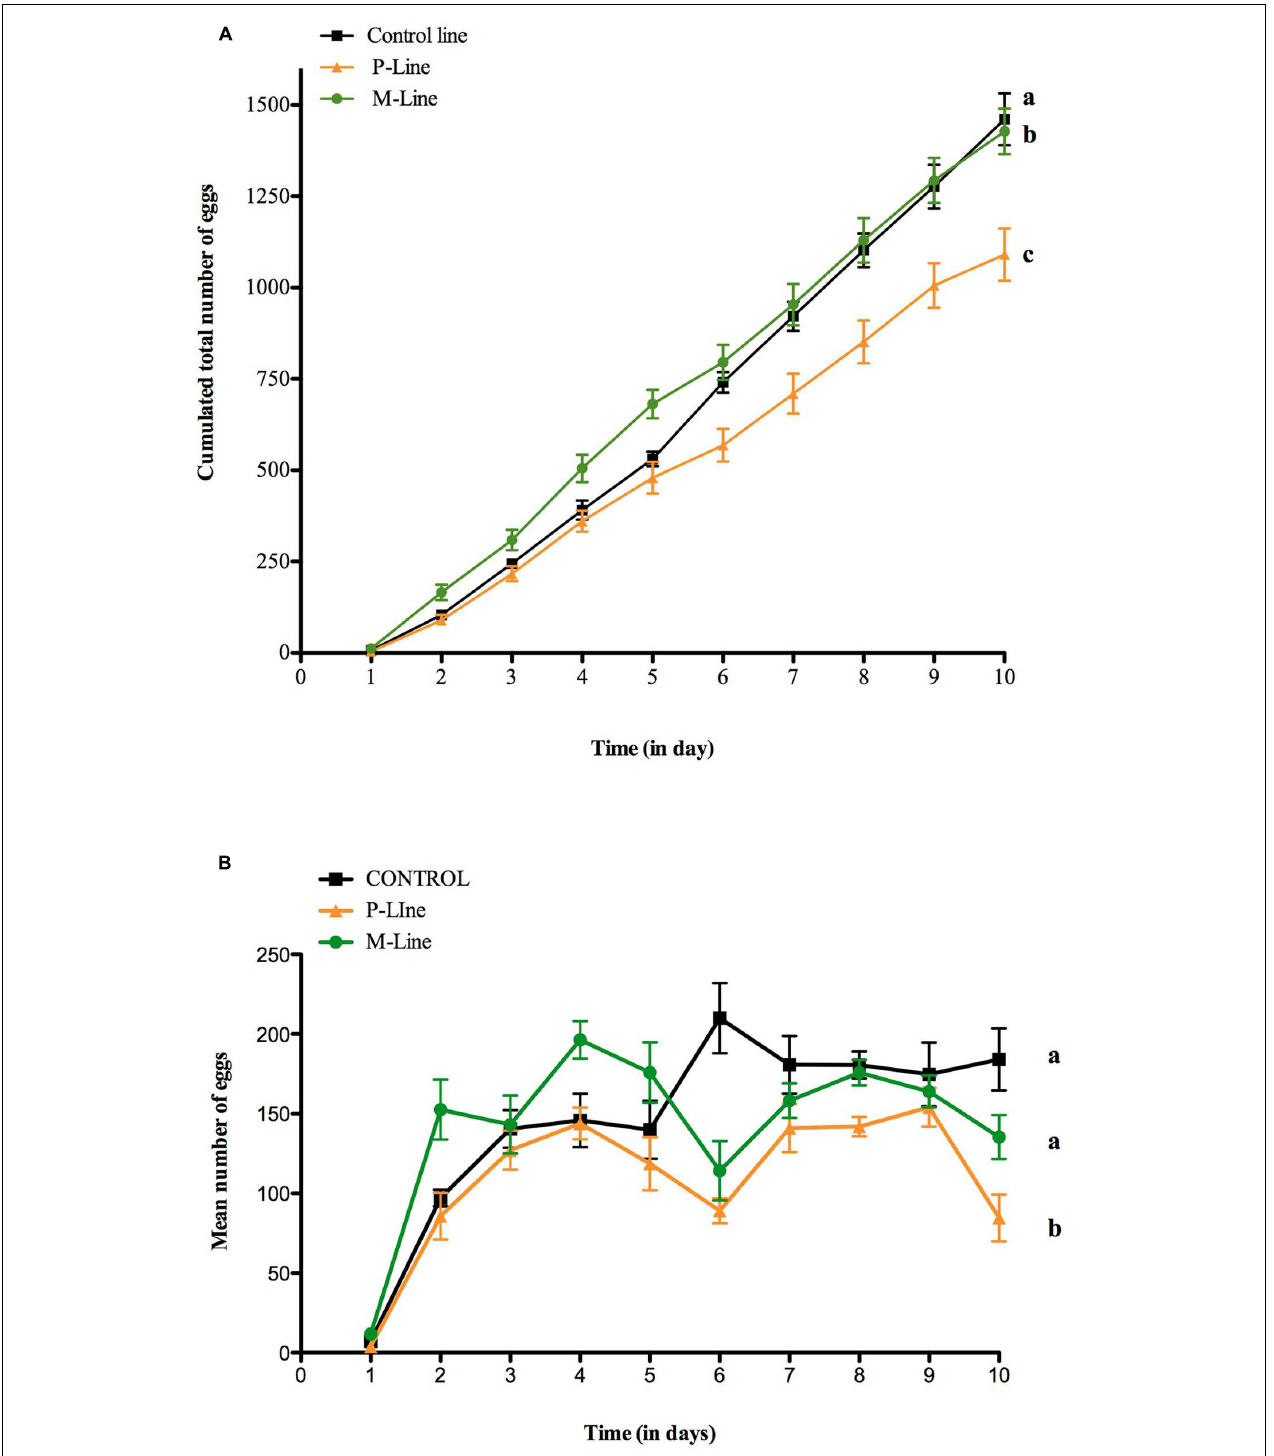
FIGURE 4 | Fecundity of D. melanogaster females during the first 10 days after emergence in an oviposition two-choice test. Control line (C-line) and the two choice-lines (P- and M-line) were tested. Mean ( ± SEM) of eggs laid by females of the three lines on two oviposition sites during 10 days after emergence. (A) Cumulated number of eggs and (B) Number of eggs laid daily. Twenty flies (10 females and 10 males) were placed in an arena containing two oviposition sites, one filled with plain-food and one filled with 0.1% menthol enriched food. Females could lay eggs for a 24 h period then the two sites were replaced by new ones. The total number of eggs laid on the two sites was counted daily. N = 8 for each line. Different letters indicate statistical difference [ANCOVA: F 3 , 236 = 916.05, p < 0.0001 for (A) and, F 3 , 236 = 28.902, p < 0.0001 for (B) ].